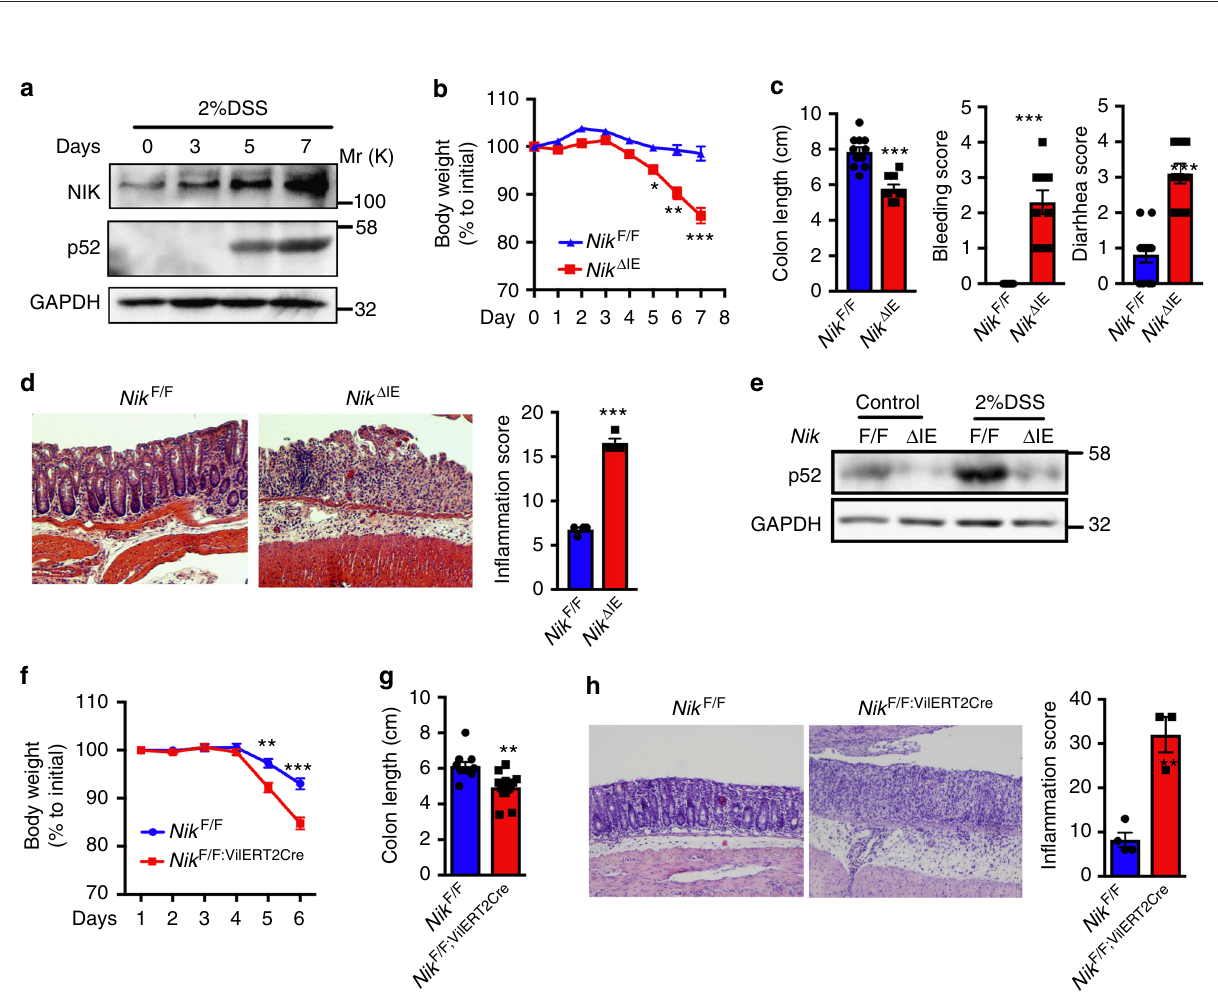
Fig. 2 Epithelial NIK signaling protects against colitis. a Western blot analysis of NIK and p52 in the colon of WT mice treated with 2% DSS for 0 – 7 days. b – d Body weight ( b ), colon length, bleeding score, diarrhea score ( c ), and H&E analysis ( d ) in Nik F/F and Nik Δ IE mice treated with 2% DSS for 7 days. e Western blot analysis of p52 in 6-week-old Nik Δ IE treated with 2% DSS for 7 days. f – h Body weight ( f ), colon length ( g ), and H&E analysis ( h ) assessed in Nik F/F and Nik F/F;VilERT2Cre mice treated with 2% DSS for 6 days. H&E images were taken at × 10 magni fi cation. Results are expressed as mean ± SEM. Signi fi cance determined using t test. * P < 0.05; ** P < 0.01; *** P < 0.001